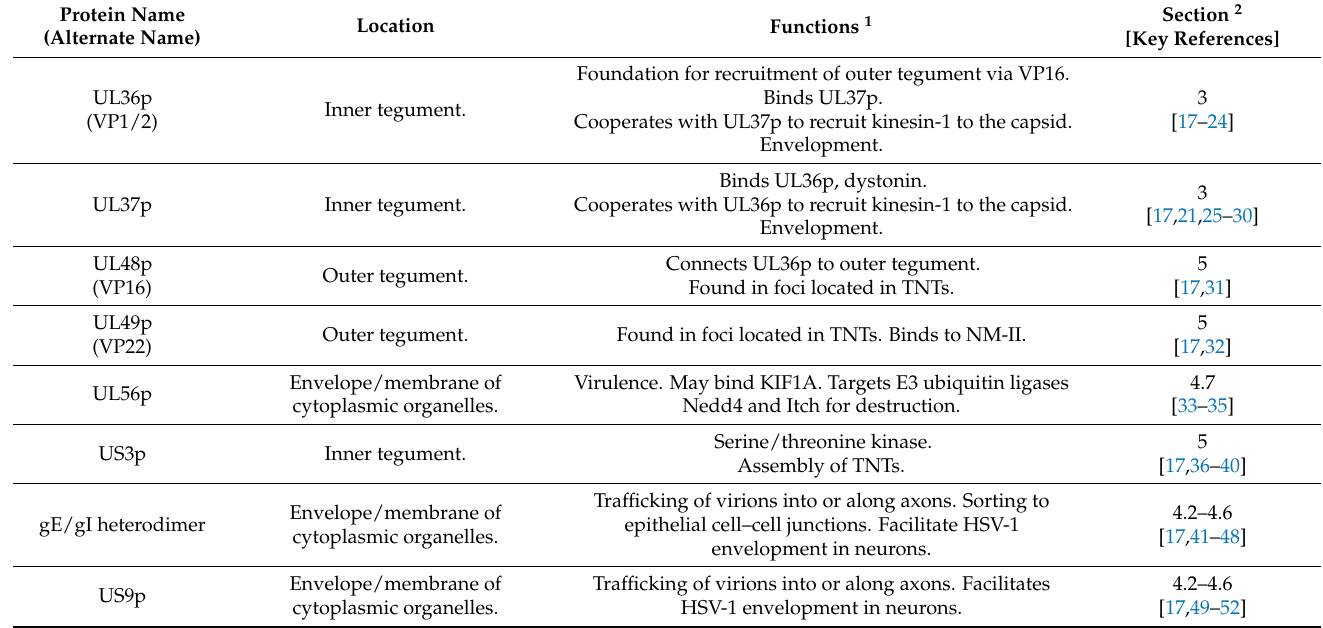
Table 1. Alphaherpesvirus-encoded proteins discussed in this review.